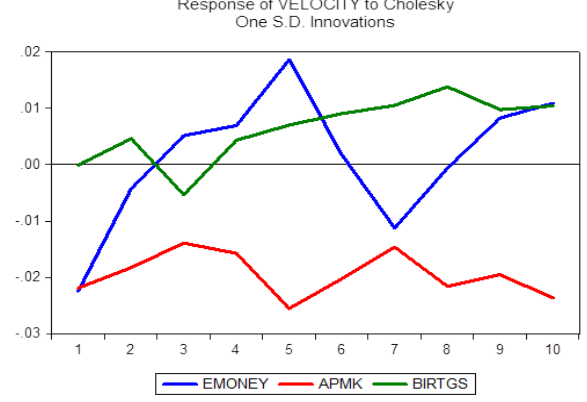
Figure 5: Response of Velocity of Money to the Shock of Non-cash Transaction